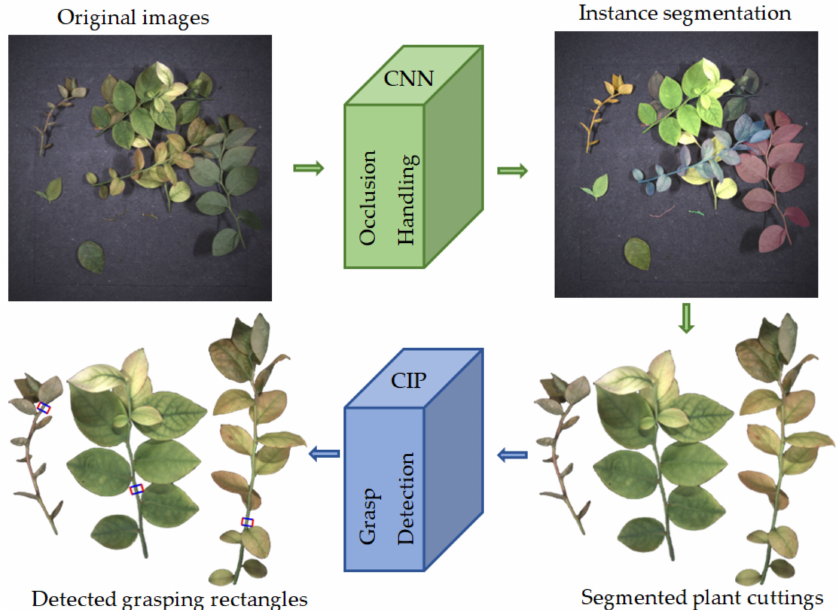
Figure 1. Pipeline of the proposed system for detection of robotic grasps of plant cuttings on a flat surface such as a conveyor